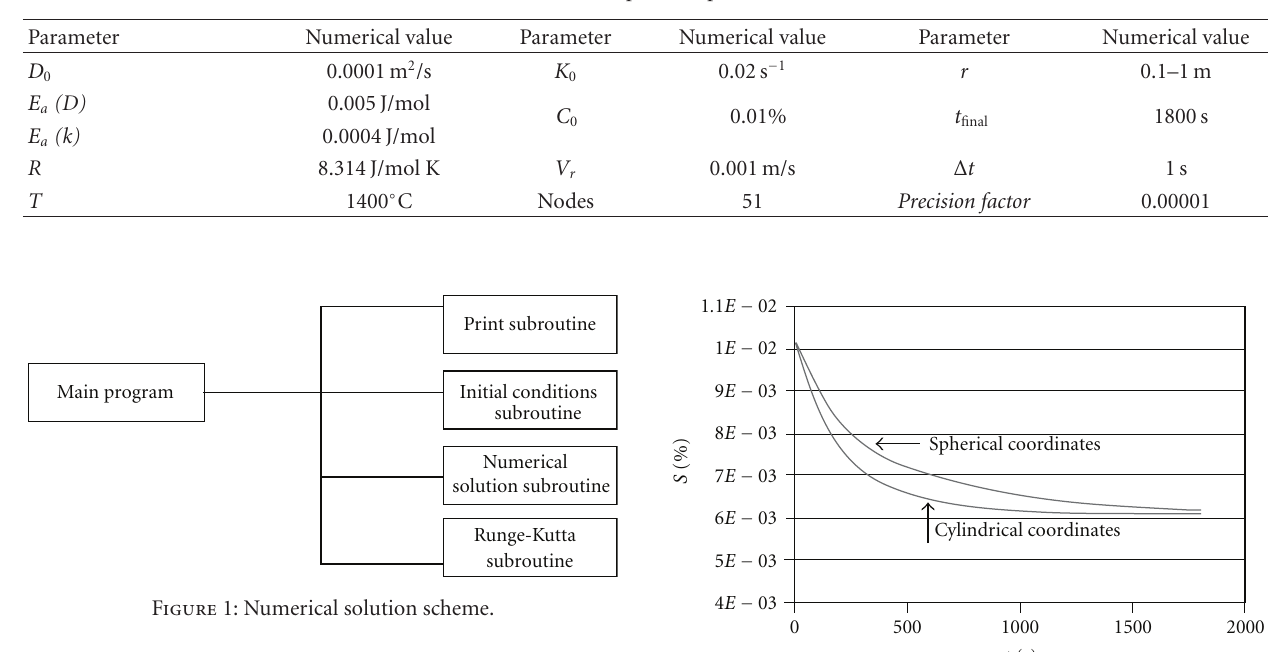
Table 2: Main operation parameters.